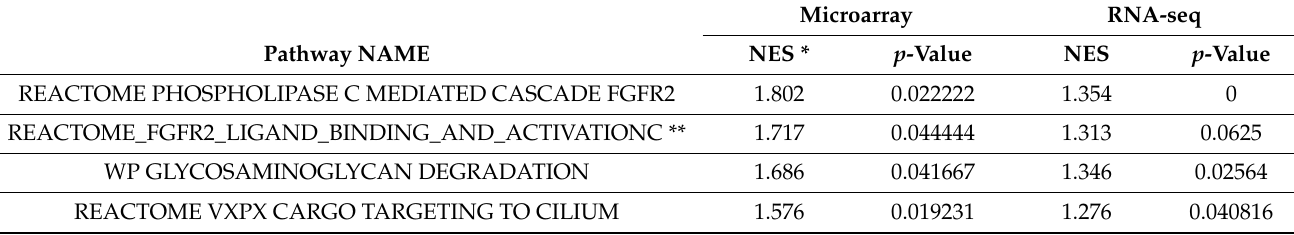
Table 3. Significantly enriched pathways highlighted in both microarray and RNA-seq series by Gene Set Enrichment analysis